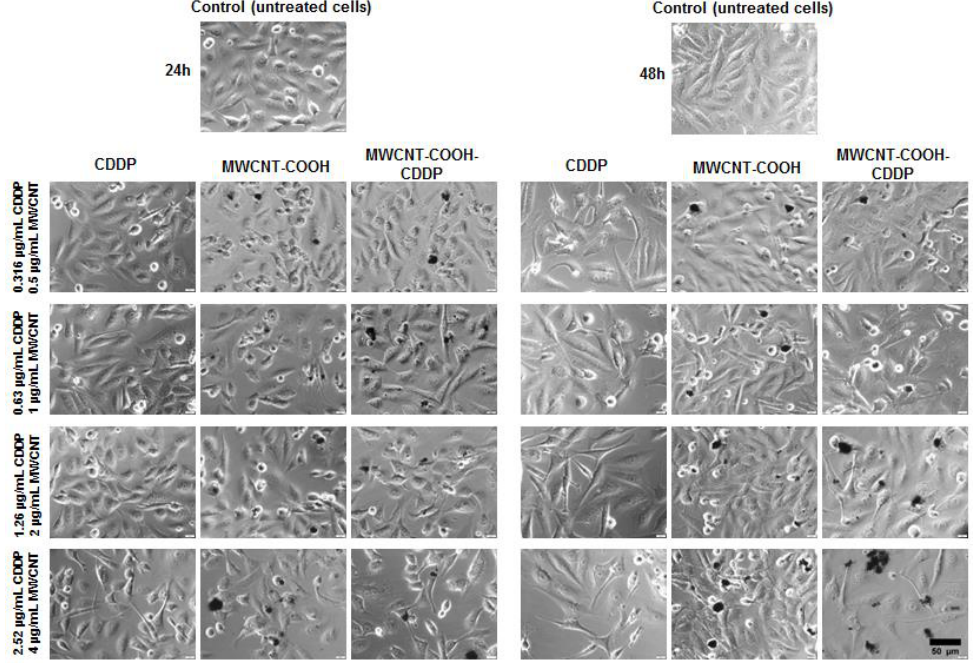
Figure 7. Bright-field images presenting the MDA-MB-231 cells morphology after exposure to various concentrations of MWCNTs (0.5–4 µg/mL) and CDDP (0.136–2.52 µg/mL) for 24 h and 48 h. Control represents untreated cells. Aggregates of CNTs are visible over the cell fields (black dots). Scale bar: 50 µm.